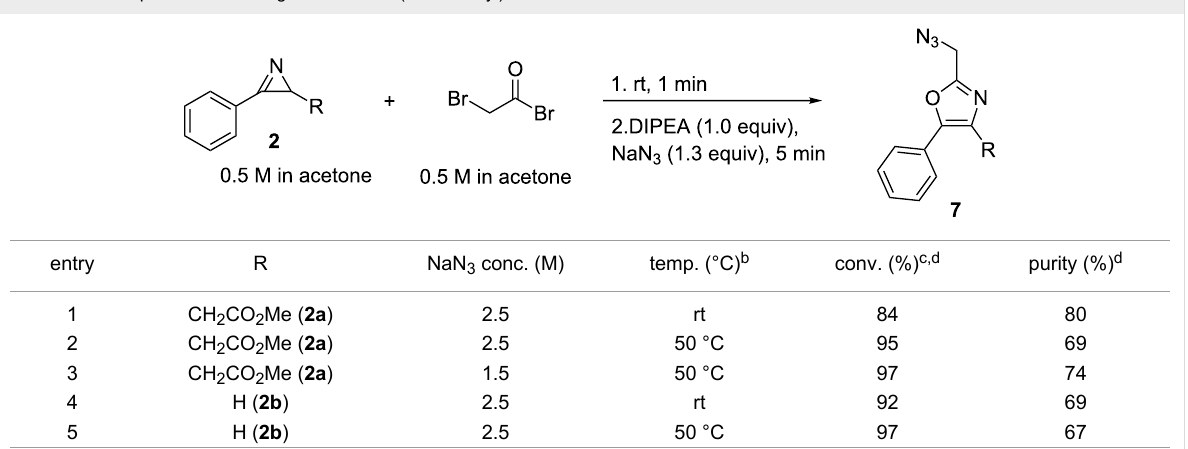
Table 3: Batch optimization of the generation of 2-(azidomethyl)oxazoles 7a and 7b . a